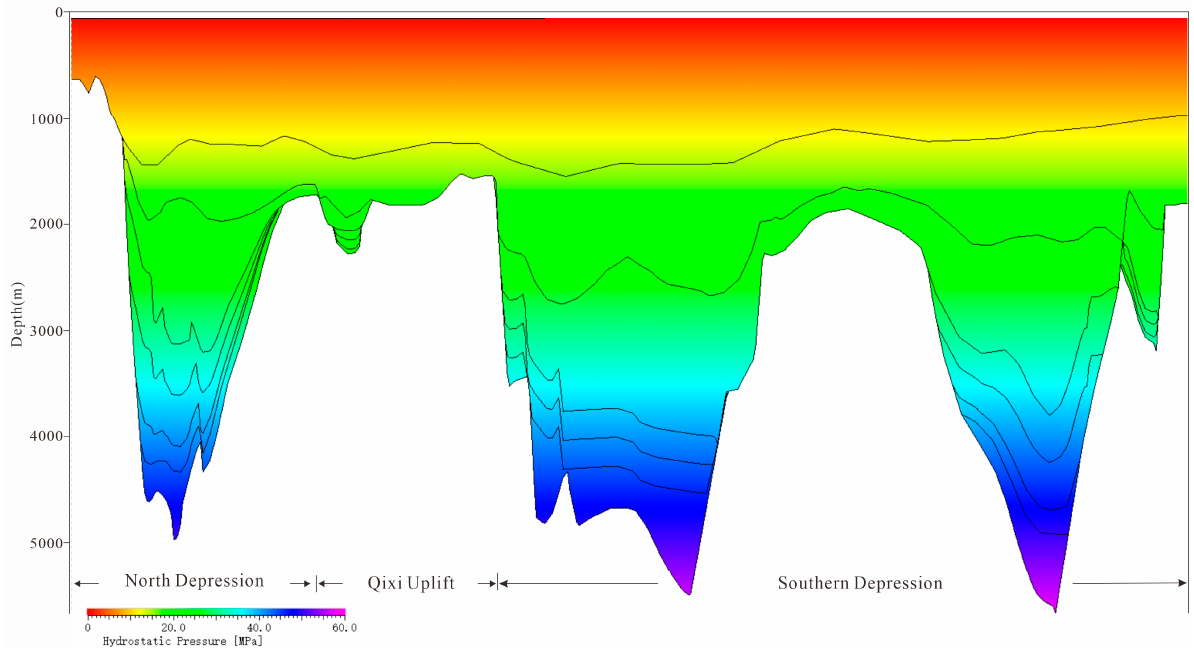
Figure 8. NW-SE formation pressure profile of the Beibu Gulf Basin (see Figure 1 for profile loca- tion).